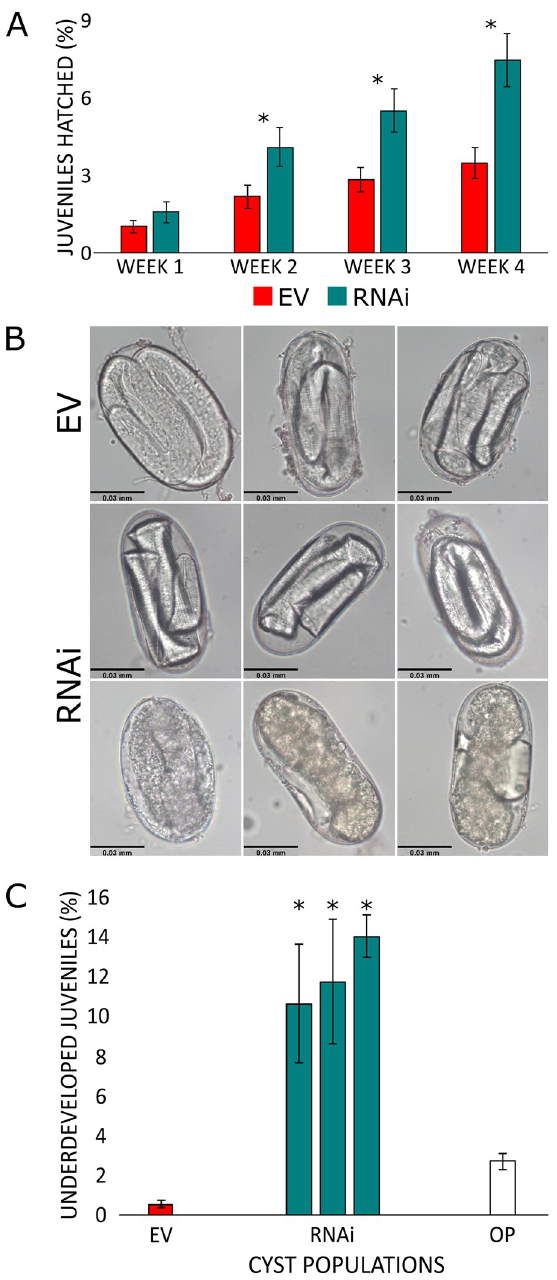
Fig 4. Annexin RNAi and effects on nematode hatching. (A) Average percentage of juveniles hatched per week. A significant increase in hatching in annexin RNAi lines (p < 0.05) was visible after 2 weeks, marked with ‘ � ’. (B) G . rostochiensis developmental changes after RNAi. Top–negative control lines using an empty vector (EV), juveniles are swollen and fill the entire eggshell. Middle- juveniles inside eggs following RNAi showing larger space in the perivitelline area between juvenile and eggshell. Bottom–eggs collected from cysts exposed to HIGS, no distinguishable juvenile morphological features are present suggesting interrupted development. (C) Percentage of underdeveloped juveniles found in negative control or RNAi cyst populations. There is a significant increase in underdeveloped juveniles in cysts populations that have reduced annexin availability as marked with ‘ � ’. Cyst populations were also compared to a sample taken from the original population of cysts used to inoculate transgenic plants (OP).